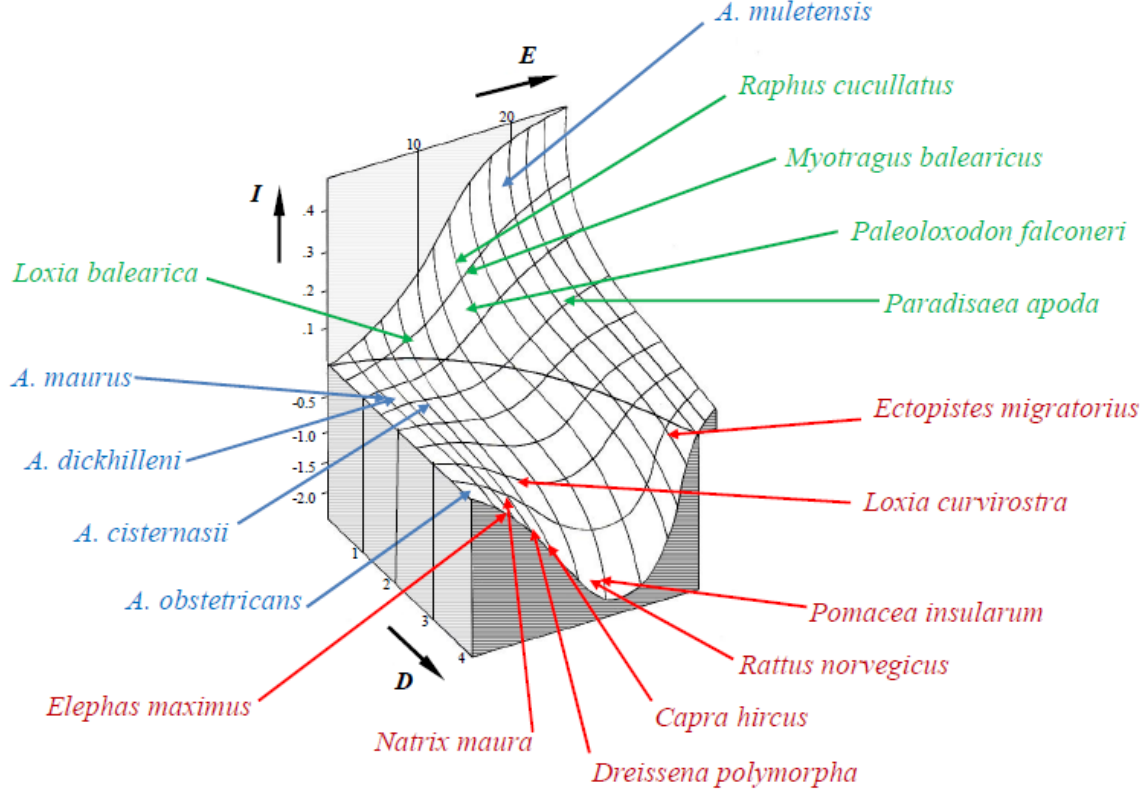
Figure 3. A predictive model of the insularity syndrome ( I ), as a function of evolutionary potential ( E ) and dispersal potential ( D ). Zero values follow a parabola separating insular and continental species. The positive range of the vertical axis is magnified five times for clarity. The position of various animal species is indicated on the surface chart; alytines in blue, insular species in green (from left to right, Mallorcan crossbill, Mauritian dodo, Balearic rat-goat, Sicilian dwarf elephant and New Guinean greater bird of paradise) and continental species in red (Asian elephant, viperine water snake, zebra mussel, feral goat, black rat, large apple snail, red crossbill and passenger